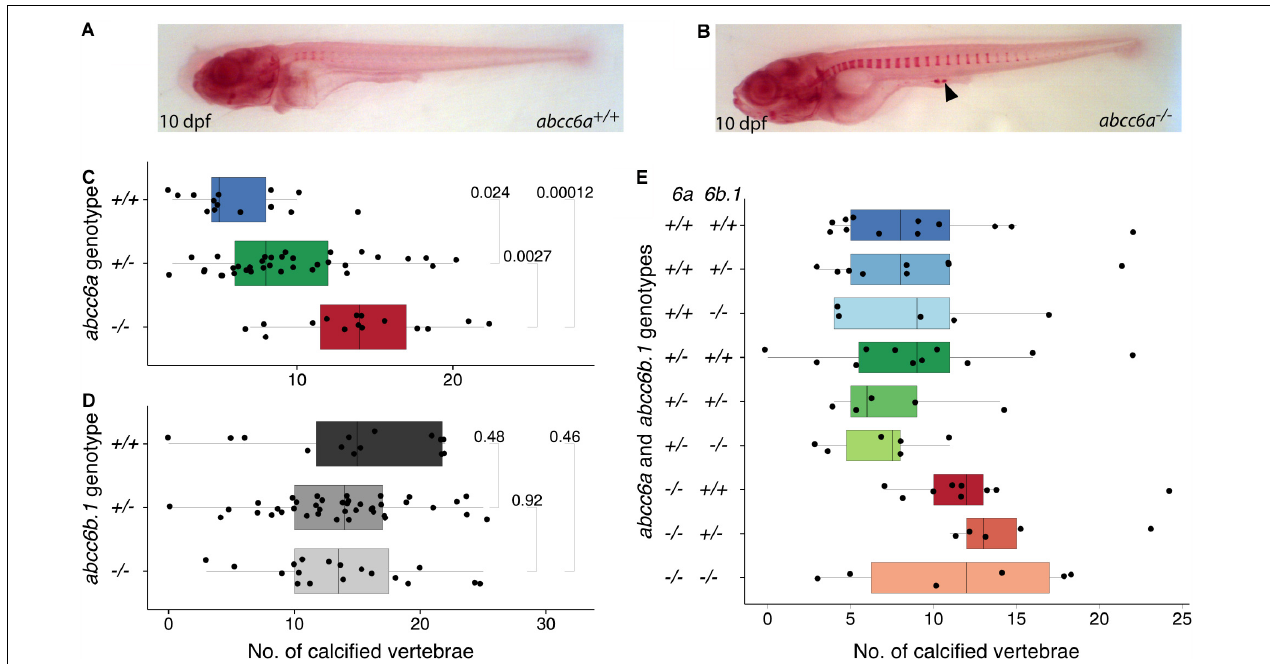
FIGURE 2 | Calcification in single and double mutants of zebrafish ABCC6 paralogs. (A,B) Alizarin Red stained 10 dpf abcc6a + / + and abcc6a − / − larvae. Ectopic calcification loci in mutants are denoted with arrowhead. (C) Quantification of calcified vertebrae in the 10 dpf progeny of abcc6a + / − carriers, plotted by genotype. The results show a significant increase in the rate of calcification in the abcc6 mutants compared to their siblings ( n = 65, significance levels calculated with Mann-Whitney test). (D) Quantification of calcified vertebrae in the 14 dpf progeny of abcc6b.1 + / − carriers, plotted by genotype. Results suggests that impairment of abcc6b.1 does not affect the rate of vertebral calcification ( n = 72, significance levels calculated with Mann-Whitney test). (E) Quantification of calcified vertebrae in the 14 dpf progeny of abcc6a + / − ;abcc6b.1 + / − carriers, plotted by genotype ( n =